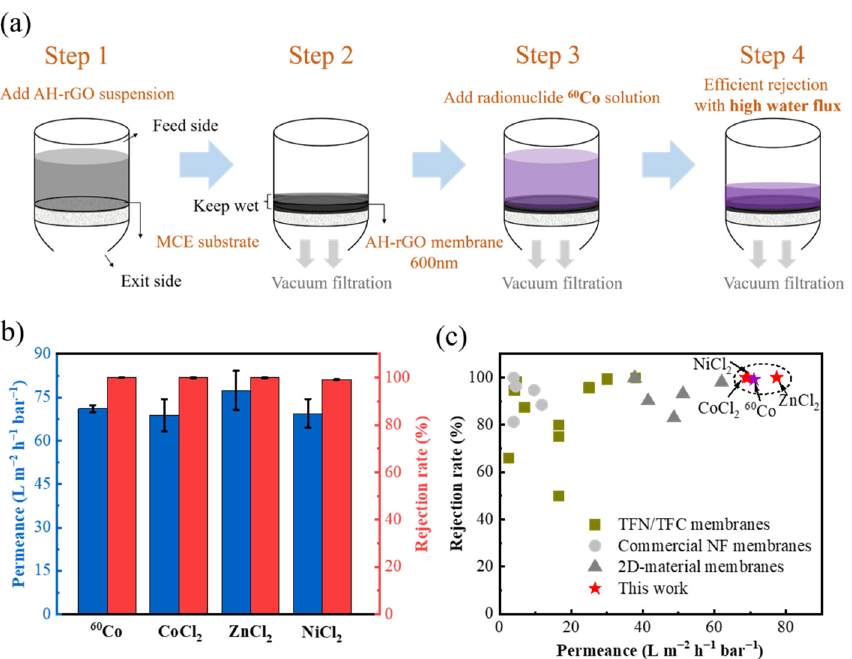
Figure 2. ( a ) A schematic of the filtration process. ( b ) Water permeance and rejection rate of AH- rGO membranes for 399 Bq/L radionuclide 60 Co and 50 mg/L CoCl 2 , ZnCl 2 , NiCl 2 solutions. ( c ) Comparisons of different nanofiltration membranes in water permeance and rejection rates for the ions (Co 2+ , Zn 2+ , Ni 2+ , and the typical divalent ion) in the literature. As shown in Figure 2b, for 50 mg/L CoCl 2 and 399 Bq/L 60 Co mixed solutions, the water permeance was 71.1 L m − 2 h − 1 bar − 1 with a high rejection rate of 99.2% through AH-rGO membranes under a pressure of 1 bar. When the 50 mg/L CoCl 2 solution is replaced by radionuclide 60 Co solution in equal amount, its specific radioactivity is about 9.6 × 10 11 Bq/L. Then, filtration experiments were further performed for other non- radioactive ions rejected by the AH-rGO membranes. The rejection rates for 50 mg/L of CoCl 2 , ZnCl 2 , or NiCl 2 solutions were 99.9%, 99.9%, and 99.9%, while the water perme- ance was 68.8, 77.4, and 69.4 L m − 2 h − 1 bar − 1 , respectively, showing high water